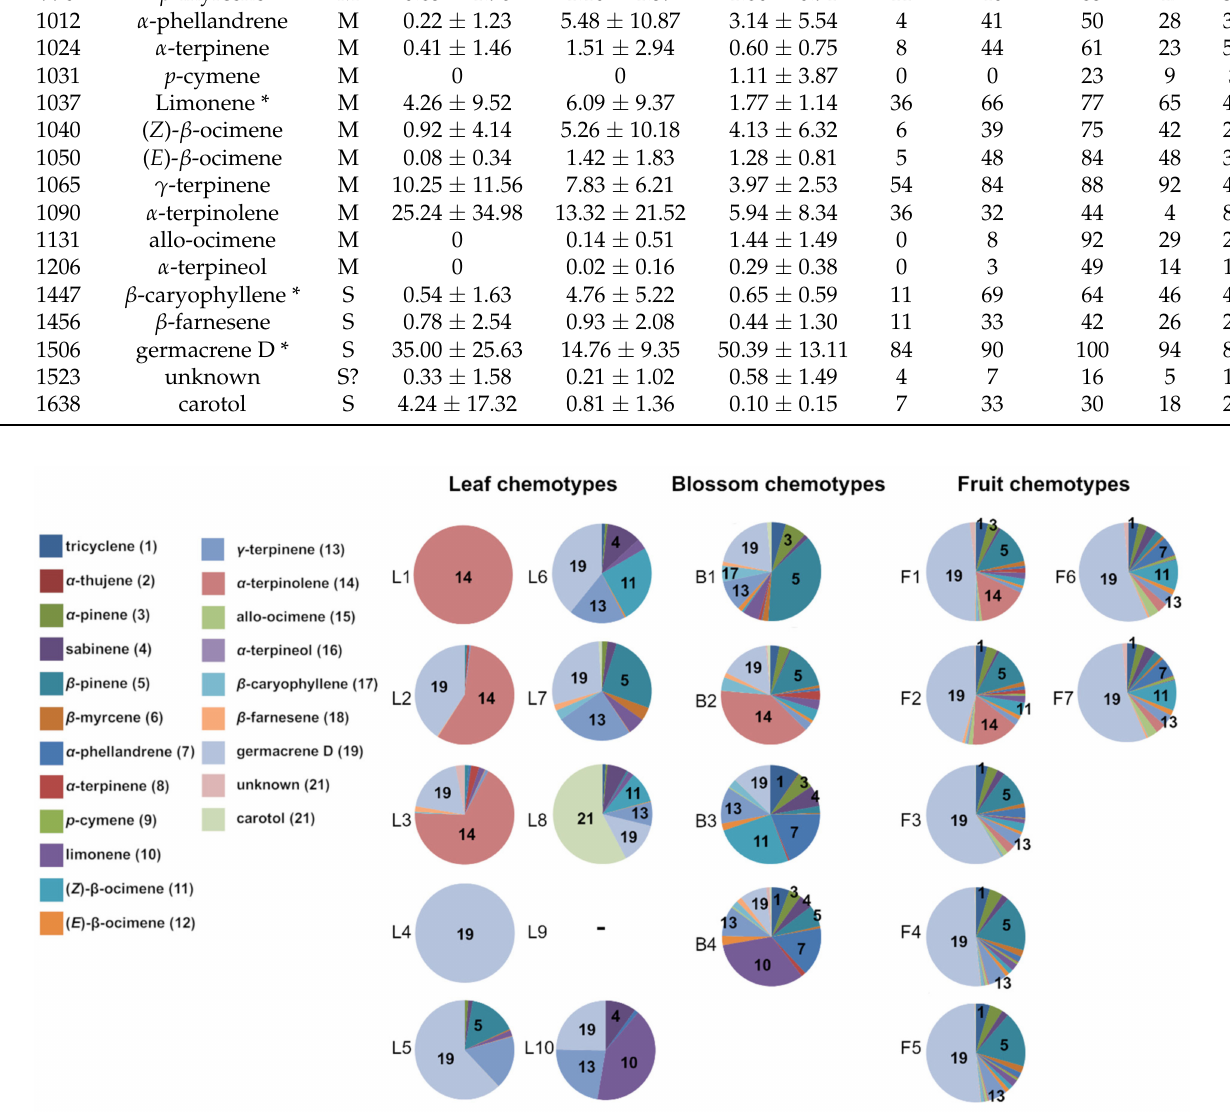
Figure 1. Relative compound abundance within each plant part-specific chemotype of Erodium cicutarium plants. Chemo- types were determined by hierarchical cluster analyses, using squared Euclidian distances and Ward’s method for linkage and by subsequently generating silhouette plots. Numbers in pie charts refer to numbers in brackets behind the compound names in the